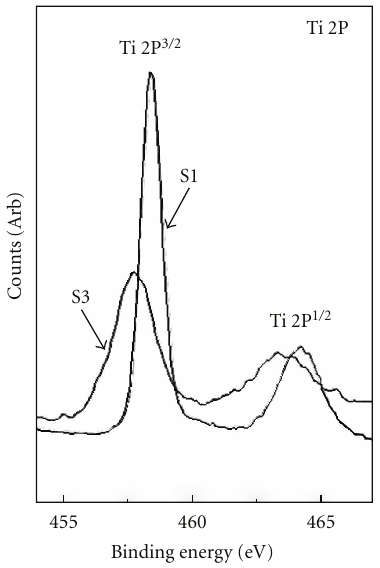
Figure 3: XPS spectrum of the Ti 2p region for the surface of S1 and